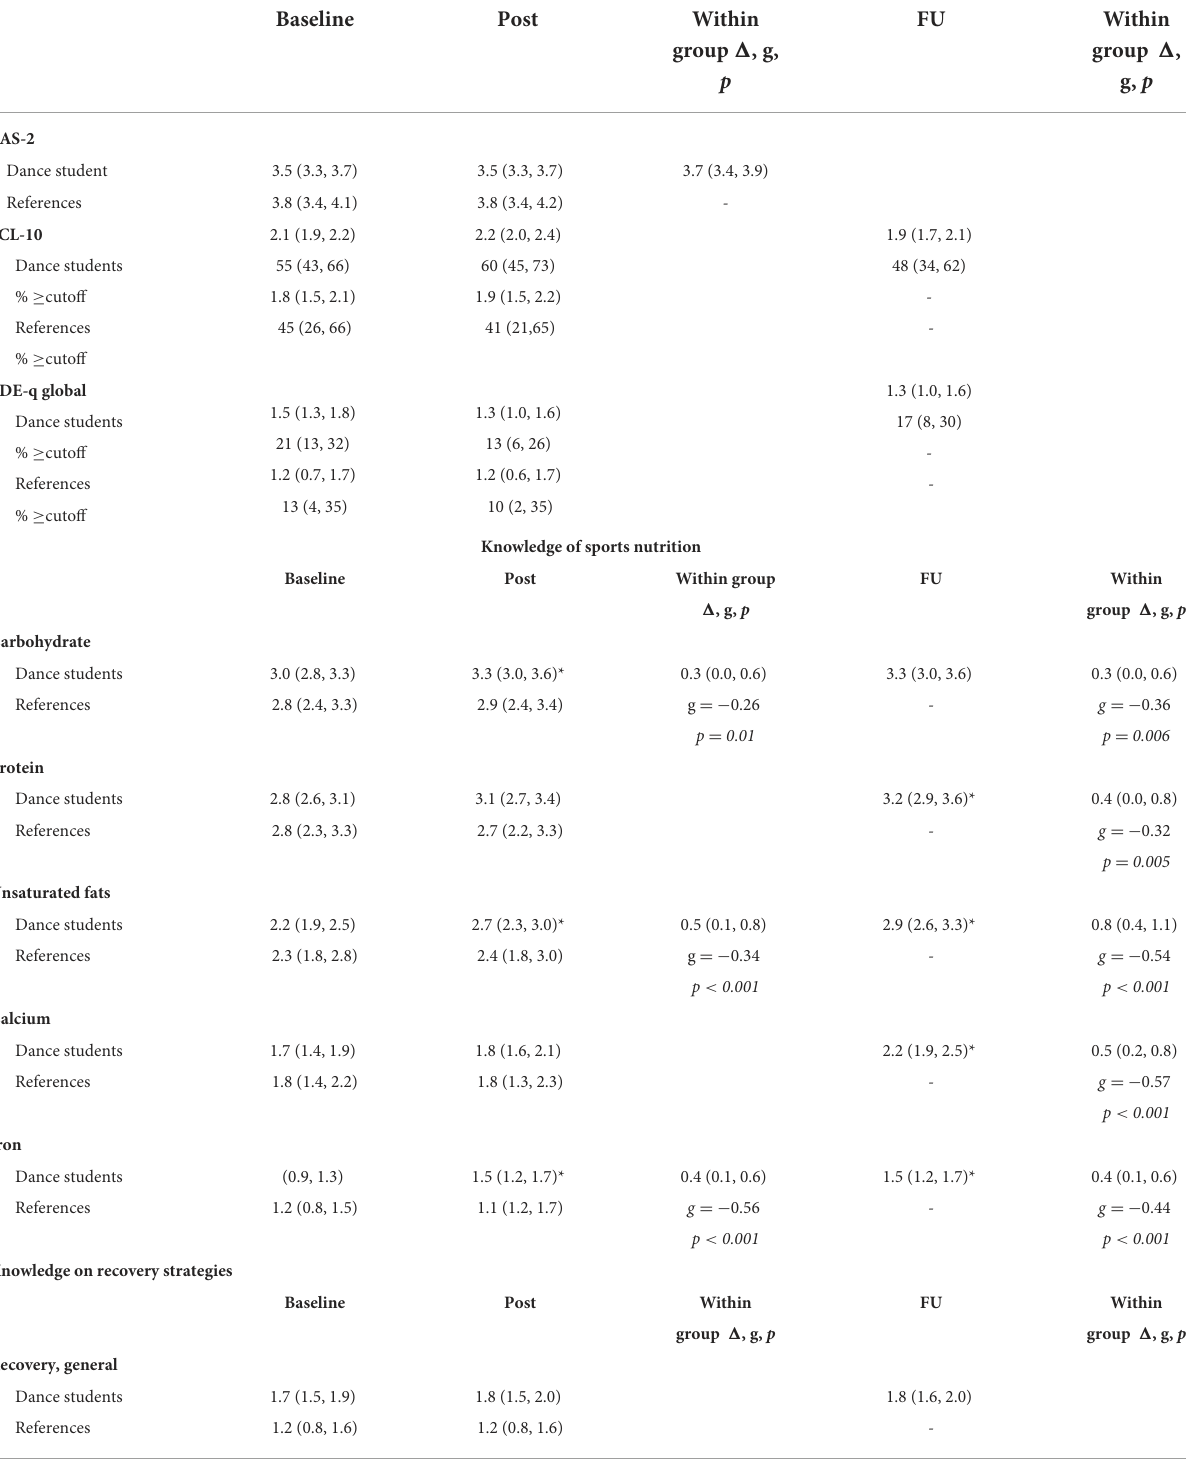
TABLE 2 Symptoms of mental health challenges, mental health literacy, and knowledge in sports nutrition and recovery strategies.